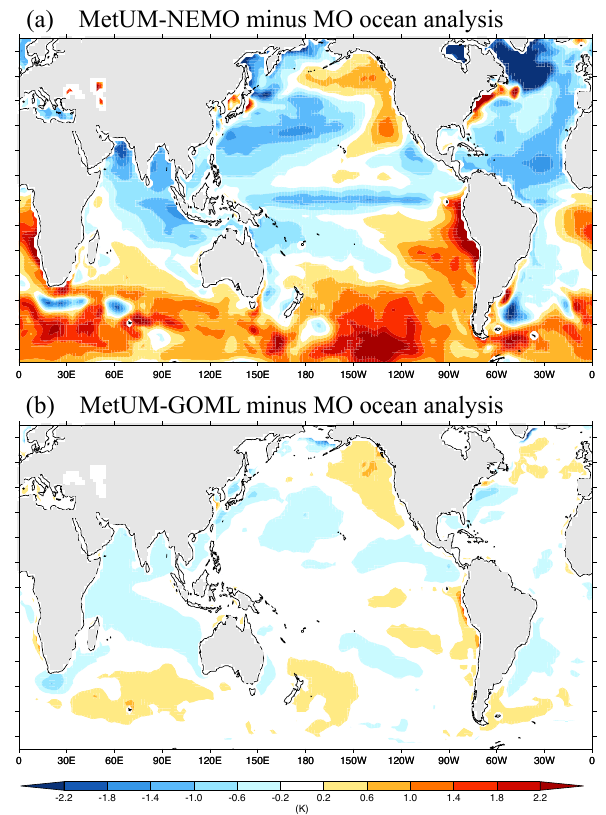
Figure 1. Annual-mean SST bias compared with the Met Office (MO) ocean analysis (Smith and Murphey, 2007). (a) 30 years of the Met Office Unified Model AGCM (MetUM) coupled to a full dynamical ocean, NEMO. (b) 60 years of a free-running MetUM- GOML simulation: the MetUM coupled to the multi-column mixed- layer ocean model, MC-KPP. The flux corrections in this MetUM- GOML simulation are calculated as described in Sect.